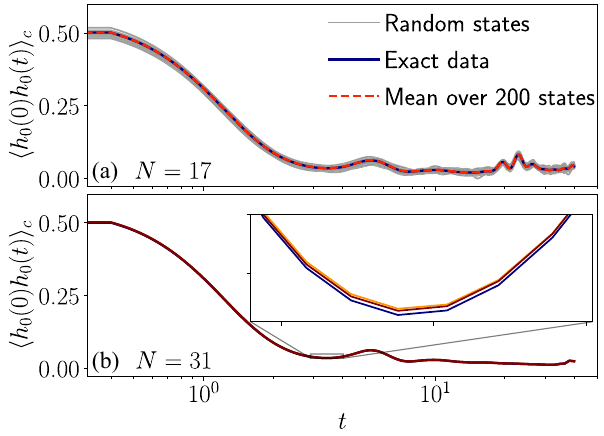
FIG. 7. (a) Comparison of the energy correlation function between random typical states and the exact time evolution. The average of random typical states matches well with the exact result. (b) Energy correlation function for three random typical states in a large system. The inset is an enlargement of one time interval showing that different typical states give very similar